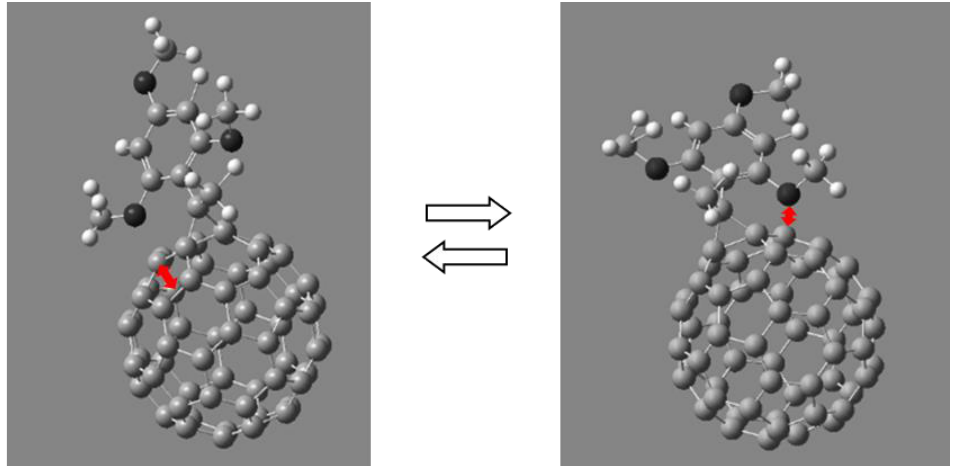
Figure 12. Interaction of alkoxy groups at the positions of the 2- and 6-phenyl substituent in the cyclopropane fragment with the π -system of the fullerene